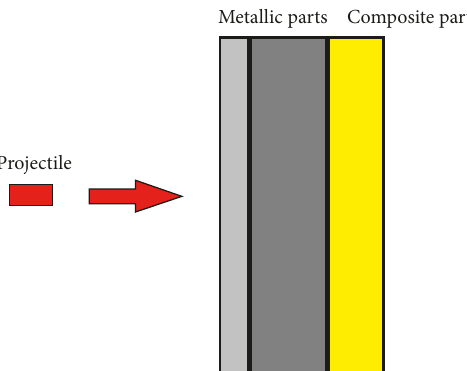
Figure 16: Schematic view of the target made with metallic parts and composite material made with 3D warp interlock